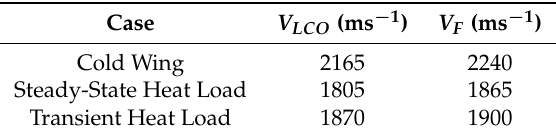
Table 1. Summary of critical aeroelastic